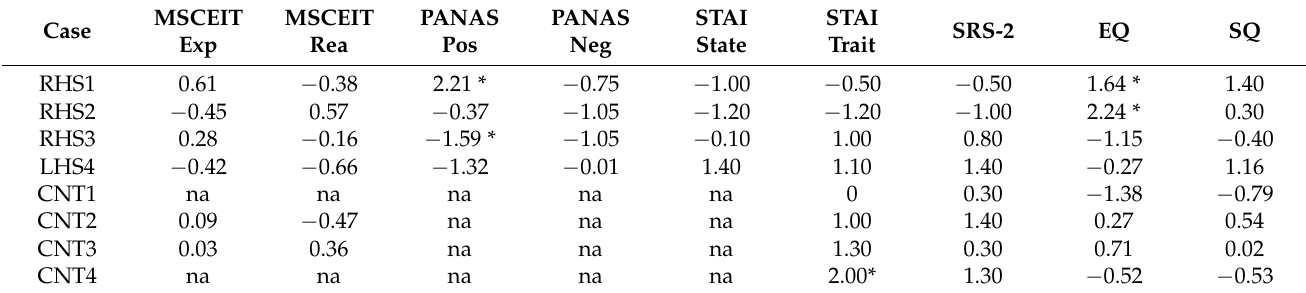
Table 3. Z-scores on Self-Report Questionnaires and an Emotion Processing Task: For all scores, higher scores indicate more of the trait being assessed. * greater than 1.5 standard deviations from the mean. MSCEIT, Mayer-Salovey-Caruso Emotional Intelligence Test; Exp, Experiencing; Rea, Reasoning; PANAS, Positive and Negative Affect Scales; Pos, Positive; Neg, Negative; STAI, State-Trait Anxiety Inventory; SRS-2, Social Responsiveness Scale-2 Adult Self-Report; EQ, Empathizing Quotient; SQ, Systemizing